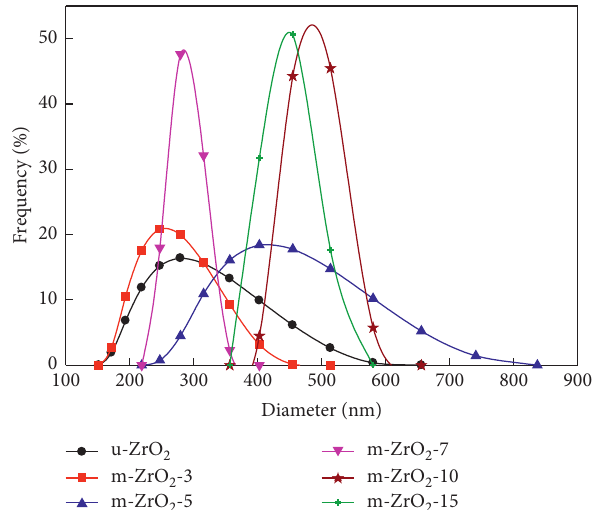
Figure 6: Size distribution of unmodified and modified ZrO